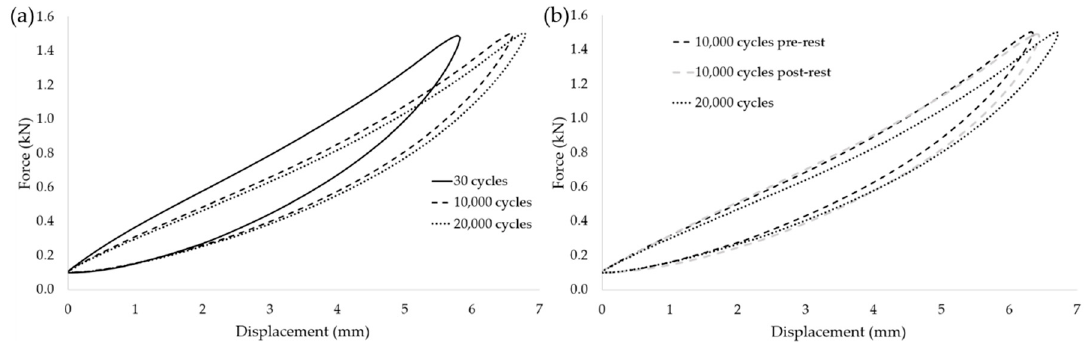
Figure 5. Force vs. displacement curves from the mechanical ageing tests (Test 1 ( a ) without and ( b ) with rest